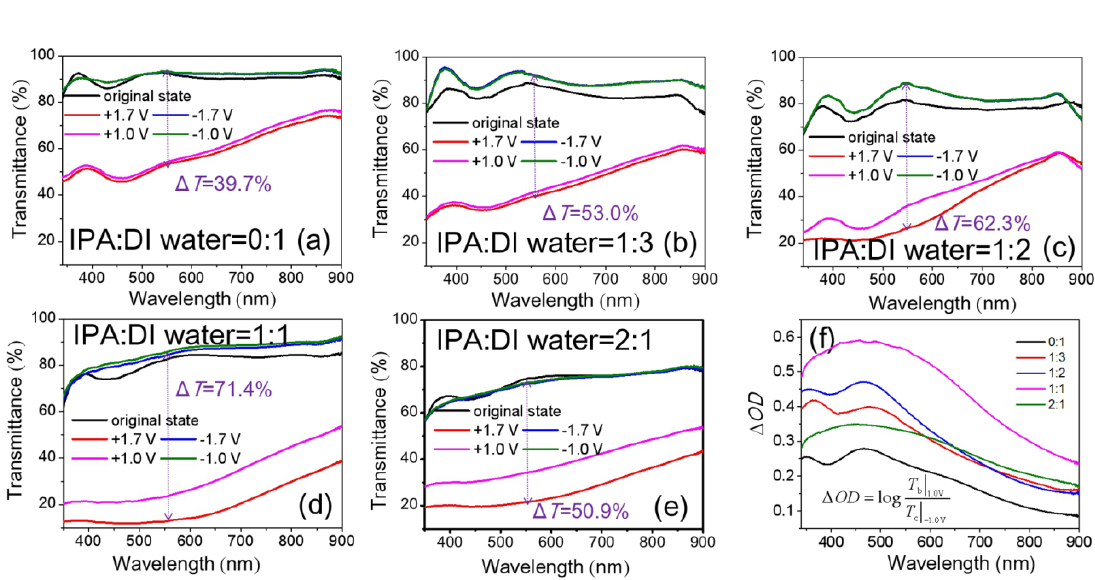
Figure 3. Optical transmittance spectra at as-deposited, colored and bleached states of NiO x films as a function of the number of spin-coating layers: ( a ) spin-coating once; ( b ) spin-coating three times; ( c ) spin-coating five times; ( d ) spin-coating seven times (the increases of voltages has little effect on the T b , so the 2 bleached curves overlap together); ( e ) Δ OD ; ( f ) Switching curve of the NiO x film by spin-coating three times. The NiO x films are annealed at 100 °C and the volume ratio in NiO x inks is IPA:DI water = 1:3.